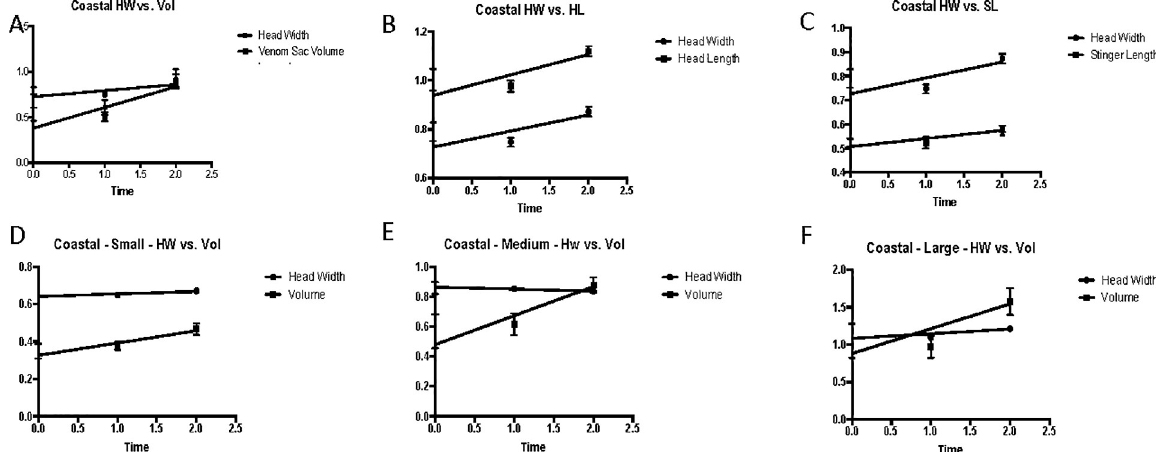
Fig 7. Linear regression analysis of coastal workers during the flood. A. Total coastal head width (HW) and volume (Vol) vs. time. B. Total coastal head width and head length vs. time. C. Total coastal head width and stinger length vs. time. D. Small coastal head width and volume vs. time. E. Medium coastal head width and volume vs. time. F. Large coastal head width and volume vs. time.